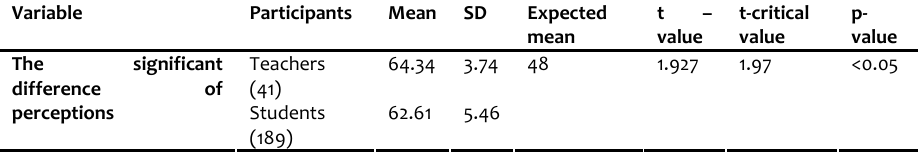
Table 6 : Teachers’ and students’ perceptions differences toward peer-led learning